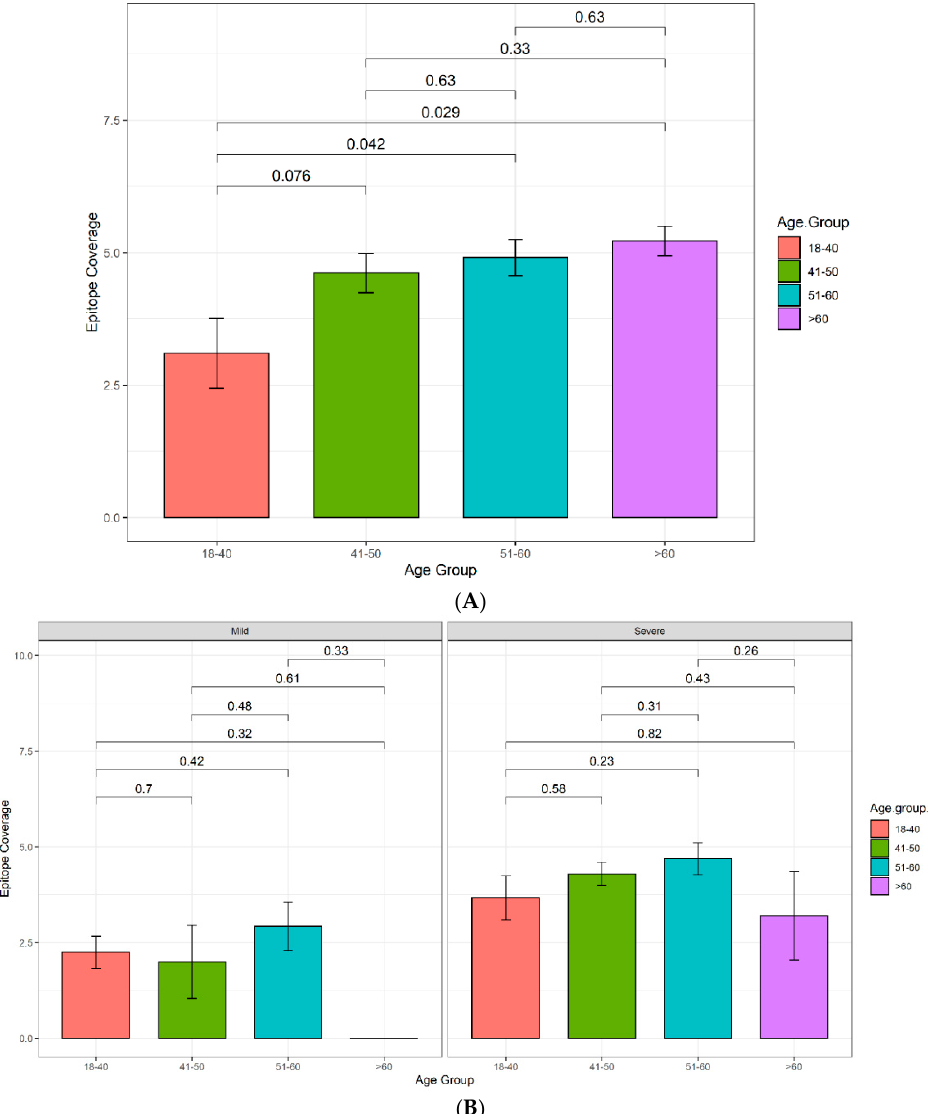
Figure 4. Histogram displaying the epitope coverage as a function of age. ( A ) Validation Cohort 2. Sample sizes: 18–40: n = 10, 41–50: n = 13, 51–60: n = 11, >60: n = 9. ( B ) Multi-ethnic Cohort 3; patients further categorized according to disease severity. Samples sizes: 18–40 mild: n = 28, severe: n = 15. 41–50 mild: n = 7, severe: n = 17. 51–60 mild: n = 14, severe: n = 13. >60 mild: n = 1, severe: n = 5.